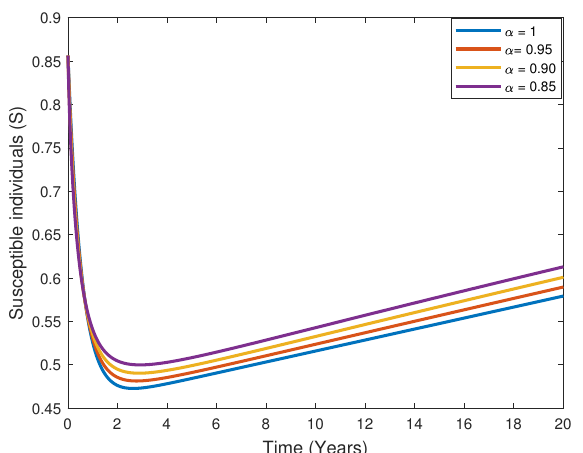
Figure 3. Behavior of S class for different α values.